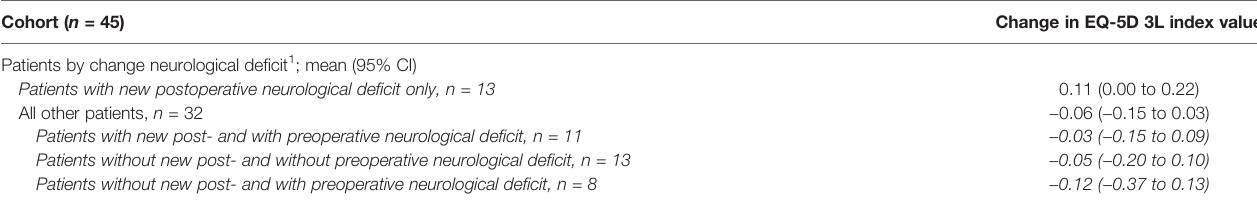
TABLE 7 | Change in the EQ-5D 3L index value in patients grouped by change in neurological de fi cit from admission to follow-up ( N = 45). Cohort ( n = 45) Change in EQ-5D 3L index value